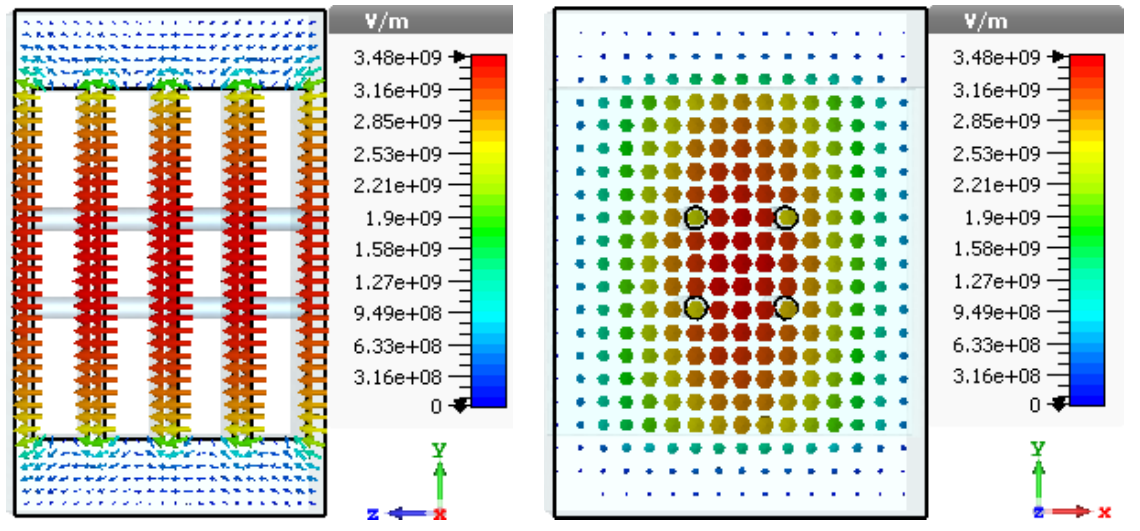
Figure 3. Electric field distribution of the 2 π mode (cut-plane view) for the intermediate cavities with